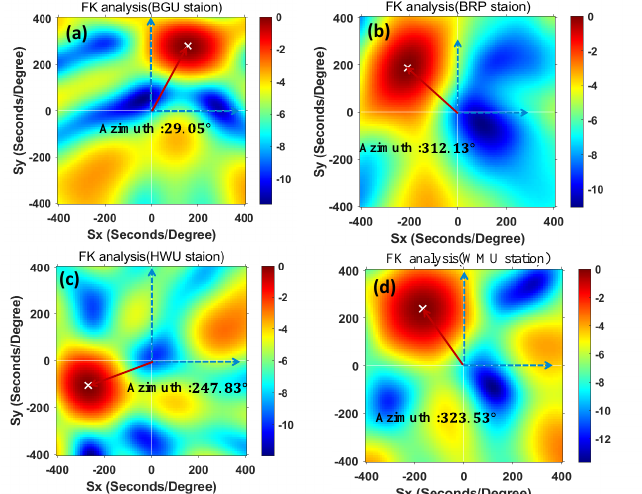
Figure 11. The azimuths from the FK analysis of the BGU, BRP, HWU, and WMU stations are ( a ) 29.05°, ( b ) 312.13°, ( c ) 247.83°, and ( d ) 323.53°,